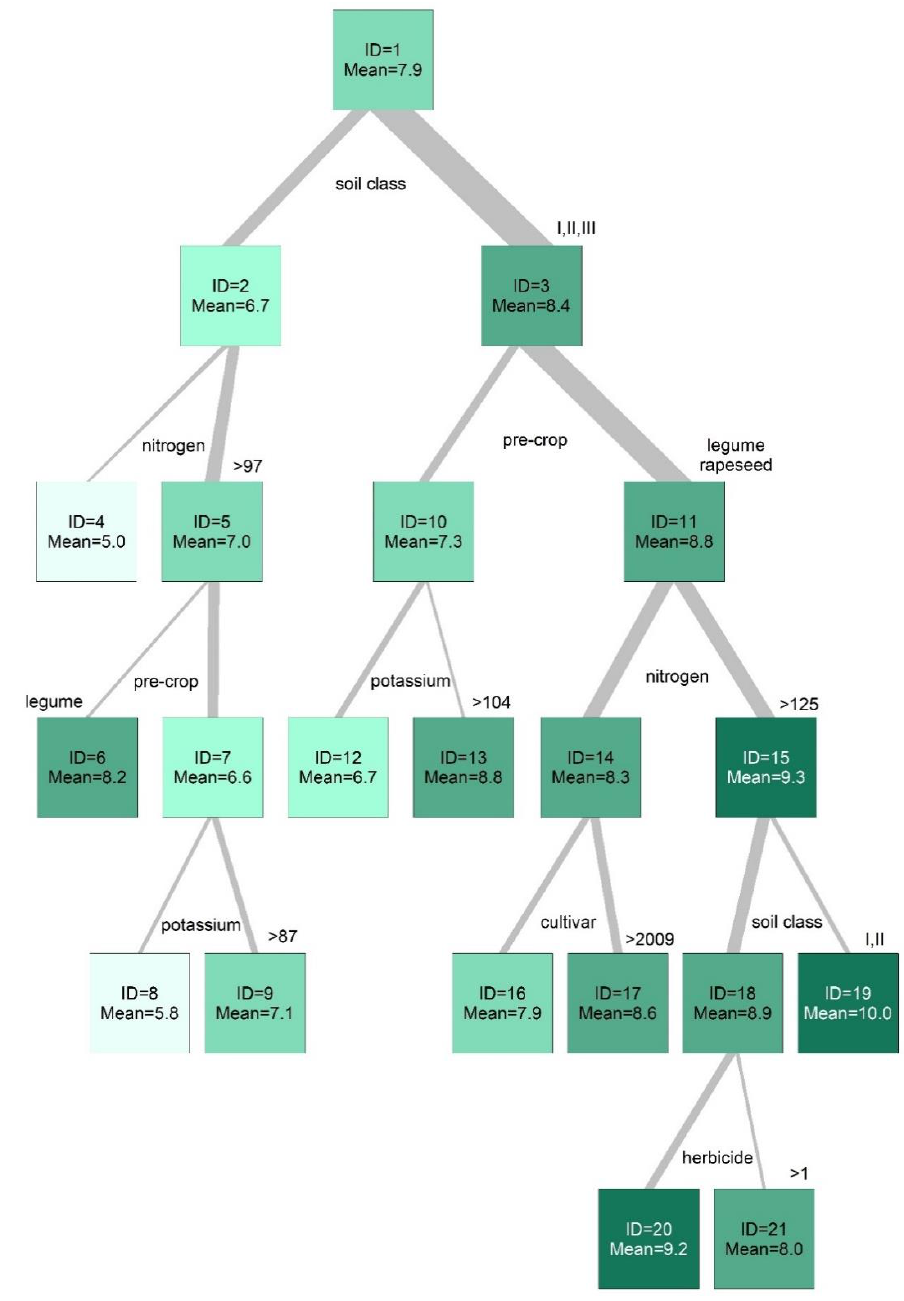
Figure 3. Regression tree for winter wheat CART analysis. Mean yield (in t/ha) is presented for each subset; the more intense the color of the subset, the higher the average yield of winter wheat. Coefficient of Pearson correlation between observed and predicted yield was 0.59.